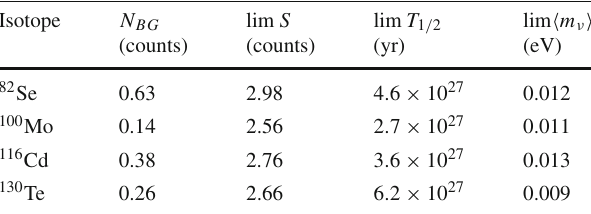
Table4 SensitivityofCUPID-1experimentswithZn 82 Se,Li 100 MoO 4 , 2 116 CdWO 130 TeO 4 and 2 detectors assuming a level of background of 4 × 10 − 6 counts/year/kg/keV. The expected background in the energy intervals ≈ ± 2 σ aredenotedas N BG .Theneutrinomasslimitslim (cid:2) m ν (cid:3) were calculated by using the matrix elements from Ref. [46], the phase space factors from Ref. [47] and the value of the axial vector coupling constant g A = 1 . 27